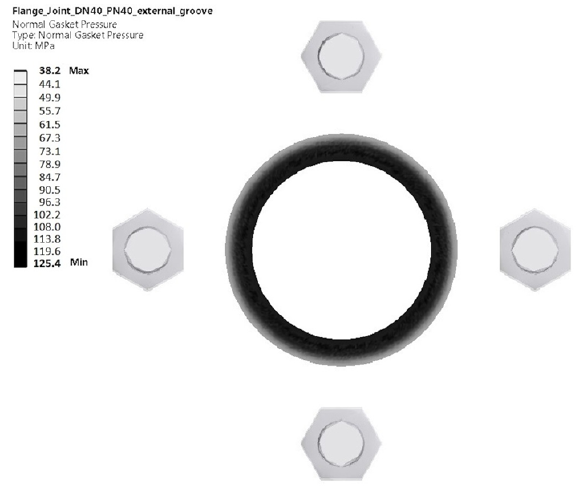
Figure 14: Contact stress distribution on the gasket surface in case of the joint gasketed with gasket’s core grooved on external side